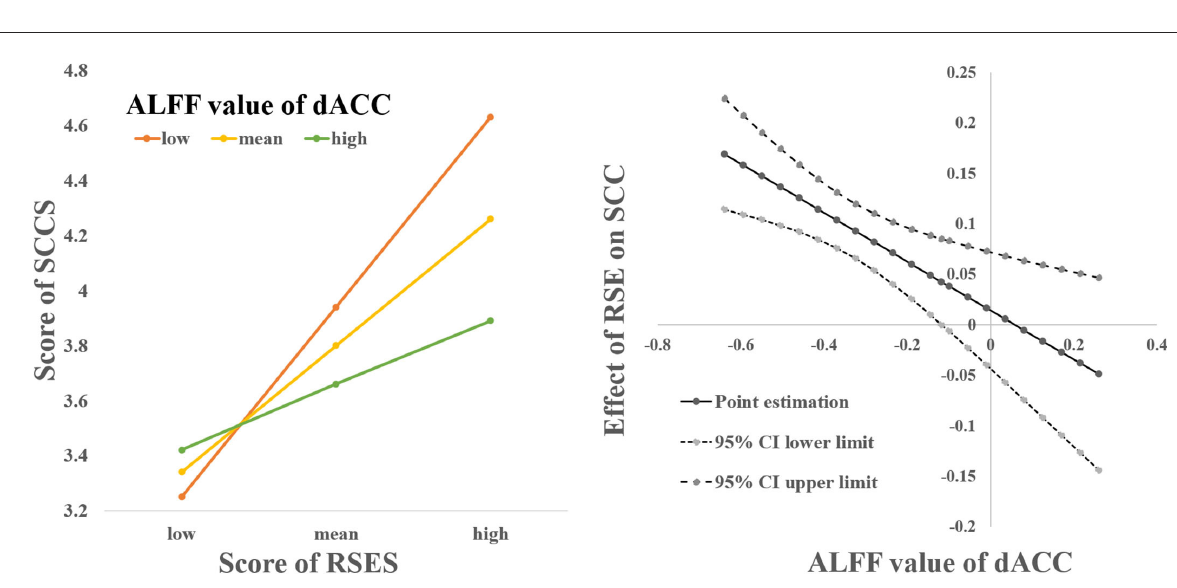
state and more sensitive to social exclusion when the ALFF value is higher. Thus, the results of the present study might support the self-determination theory, which implies that the positive relationship between self-concept clarity and self-esteem is lower when relatedness is chronically